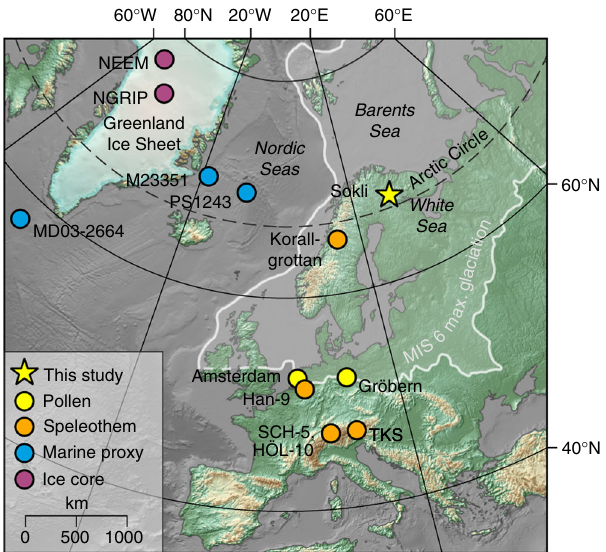
Fig. 1 Location of Sokli and key sites referenced in the study. Maximum extent of glaciation during the Saalian ice age (Marine Isotope Stage 6) 13 is